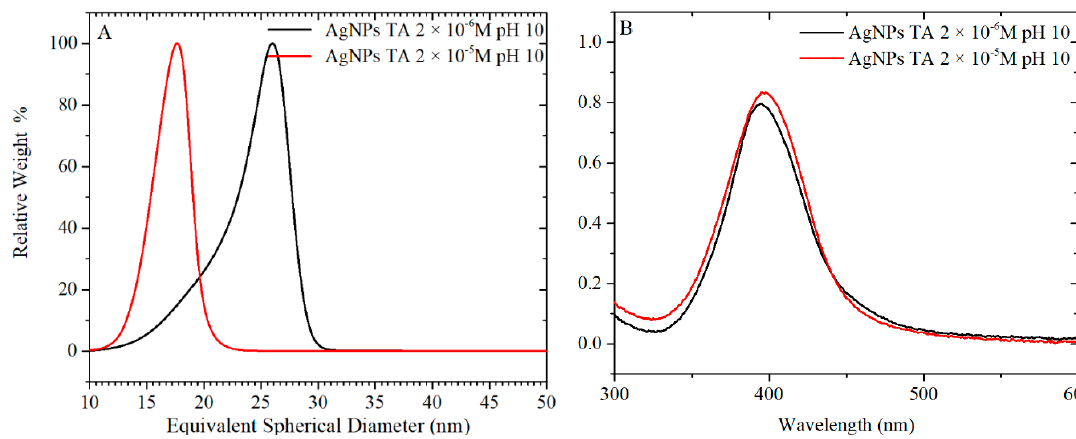
Figure 10. ( A ) CLS and ( B ) UV-vis of AgNPs synthesised by preconditioning TA at pH 10 for 24 h: TA were used at concentrations of 2 × 10 − 6 and 2 × 10 − 5 M.